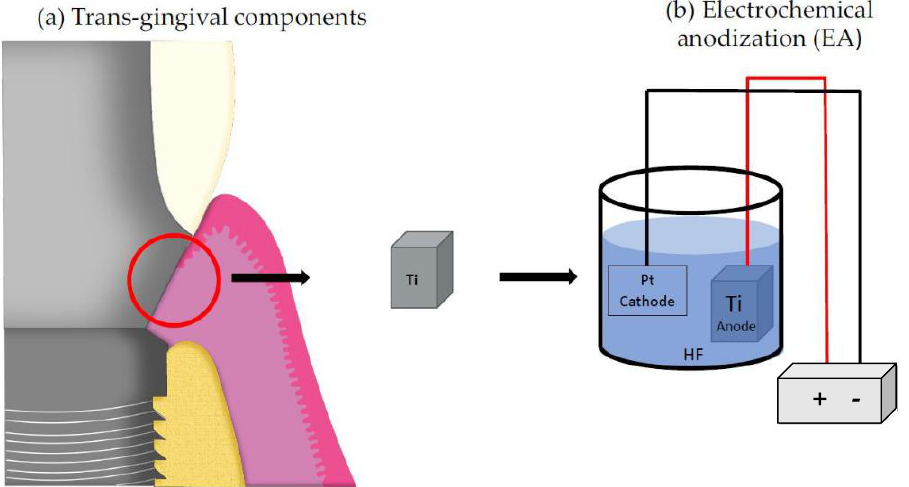
Figure 1. Schematic representation of ( a ) the trans-gingival abutment-mucosa interface and ( b ) the electrochemical anodization step to fabricate TiO 2 nanotubes or nanopores. This specific nano-featured surface is characterized by the presence of nanopores (NP) or nanotubes (NT) whose morphology (diameter, length, wall thickness) and surface chemistry (crystallinity) vary according to the experimental conditions [4] (Figure 2).